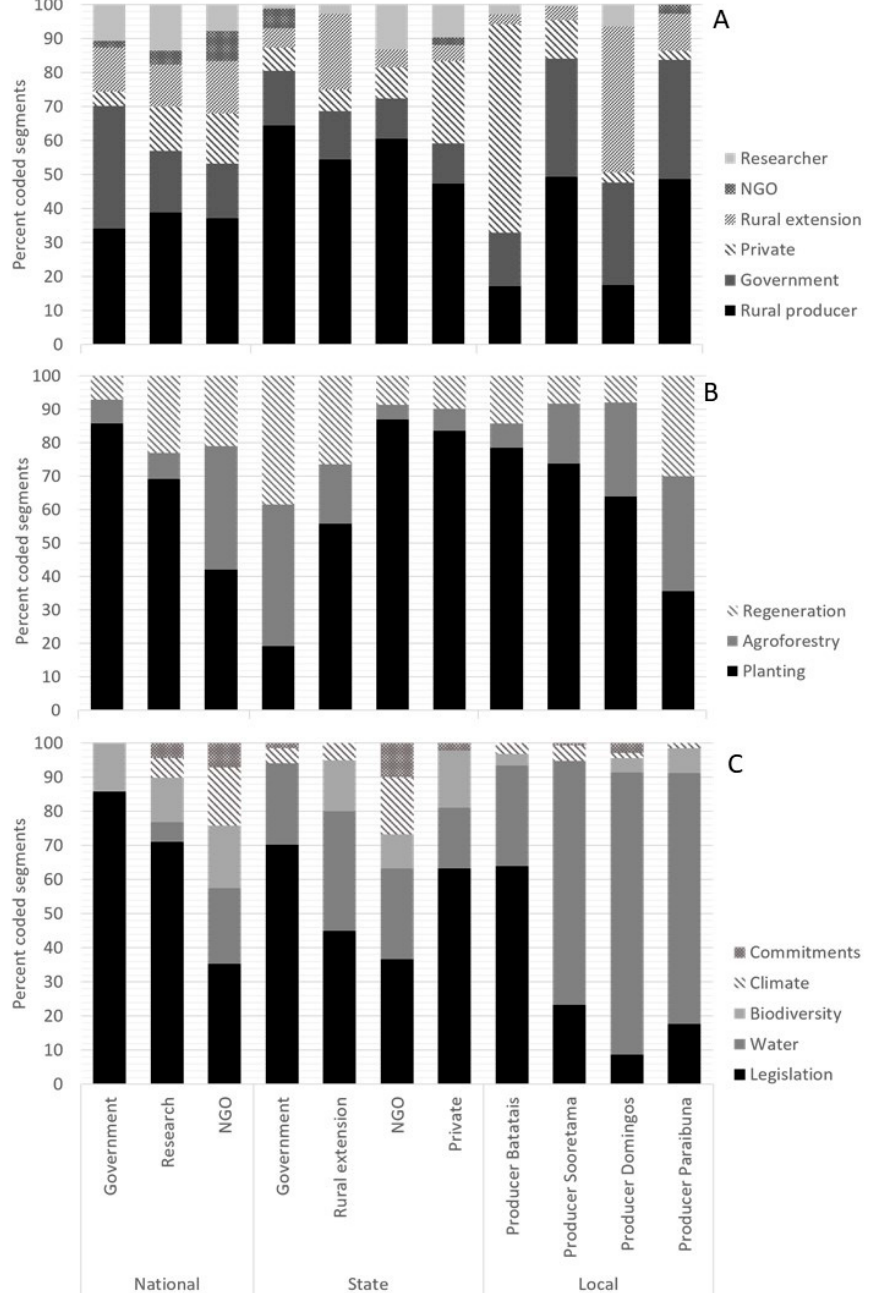
Figure 3. Percent coded segments for the different contextual themes. ( A ) actor type; ( B ) restoration method; ( C ) restoration drivers.